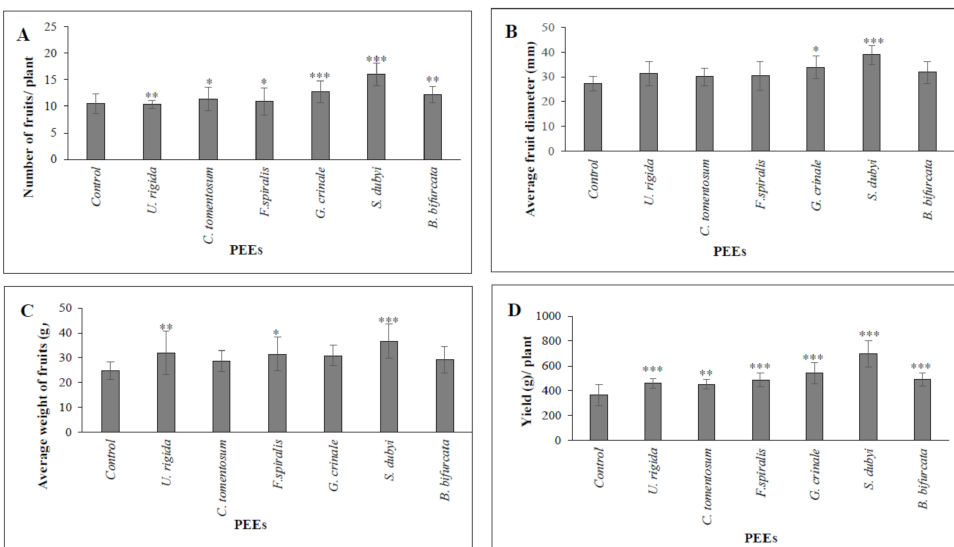
Figure 1. Fruit yield parameters of greenhouse-grown tomato plants treated 4 times (1 application after transplantation, 2 applications during the vegetative phase of growth, and 1 last application during the reproduction phase) with PEEs treatments. ( A ) Number of fruits per plant; ( B ) average of fruit diameter (mm); ( C ) average fruit weight (g); ( D ) yield of accumulated fruits per plant). The data represent the mean values of 15 repetitions with standard deviations indicated by vertical bars. * Significant difference compared to the control treatment by ANOVA analysis ( p ≤ 0.05) *** = p ≤ 0.001; ** = p ≤ 0.01; * = p ≤